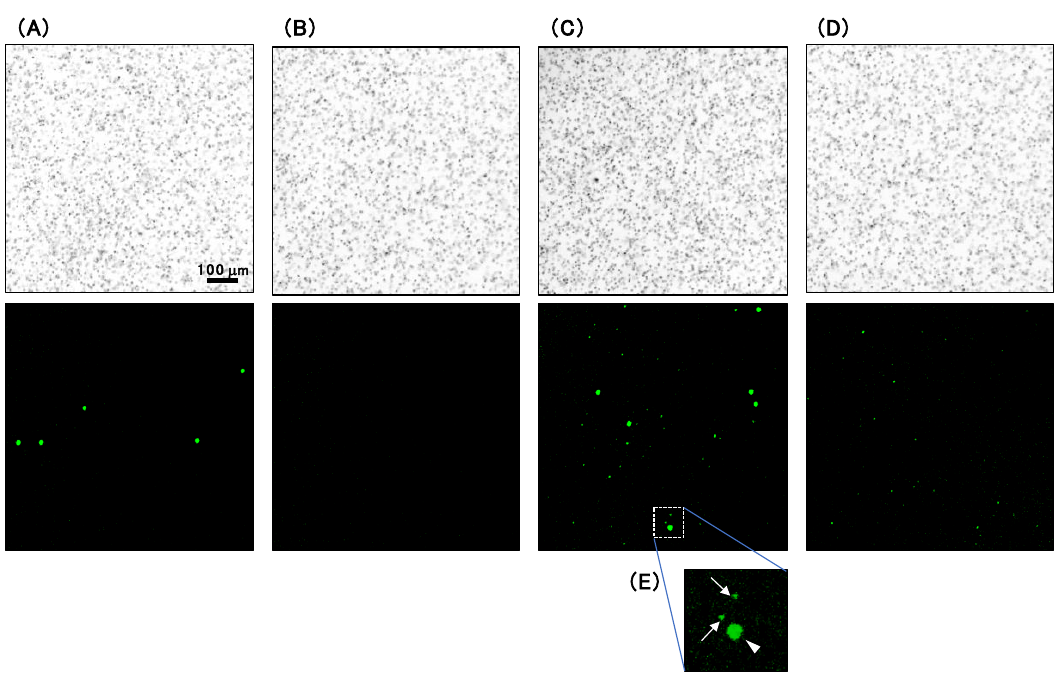
Figure 4. Bright-field and fluorescent images captured using CQ1. Whole blood ( A ), whole blood after filtration ( B ), whole blood spiked with parasite-infected erythrocytes ( C ), and whole blood spiked with parasite-infected erythrocytes after filtration ( D ) was analyzed via CQ1. Each sample was stained with Cellstain AO solution. Typical bright-field (upper panels) and fluorescence images (lower panels) are depicted. ( E ) An enlarged image of ( C ) is presented. A leucocyte is indicated by an arrowhead, and parasites are indicated by arrows.